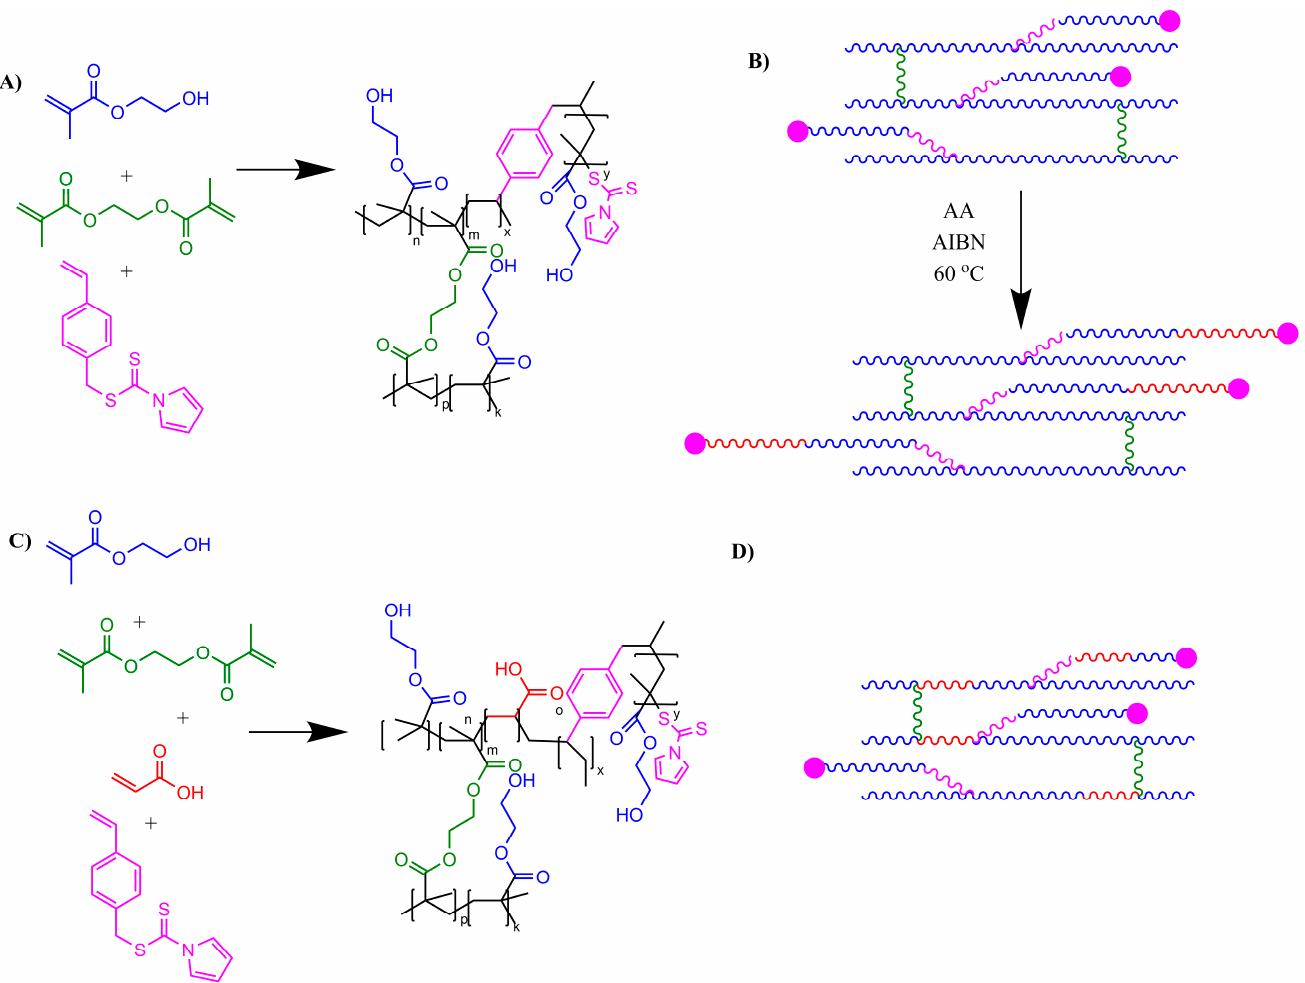
Figure 1. ( A ) Chemical structure of crosslinked hydrogels prepared by thermal initiation of HEMA (blue), EGDMA (green) and RAFT (pink) ( PCG 2 ). ( B ) Grafting of PAA chains (red) onto HEMA via RAFT chain extension ( PCG 2B ). ( C ) Chemical reaction route to prepare hydrogels copolymerized with statistical AA comonomer in initial reaction feed ( PCG 3 ). ( D ) Overall structure of copolymer AA throughout HEMA gel ( PCG 3 ).